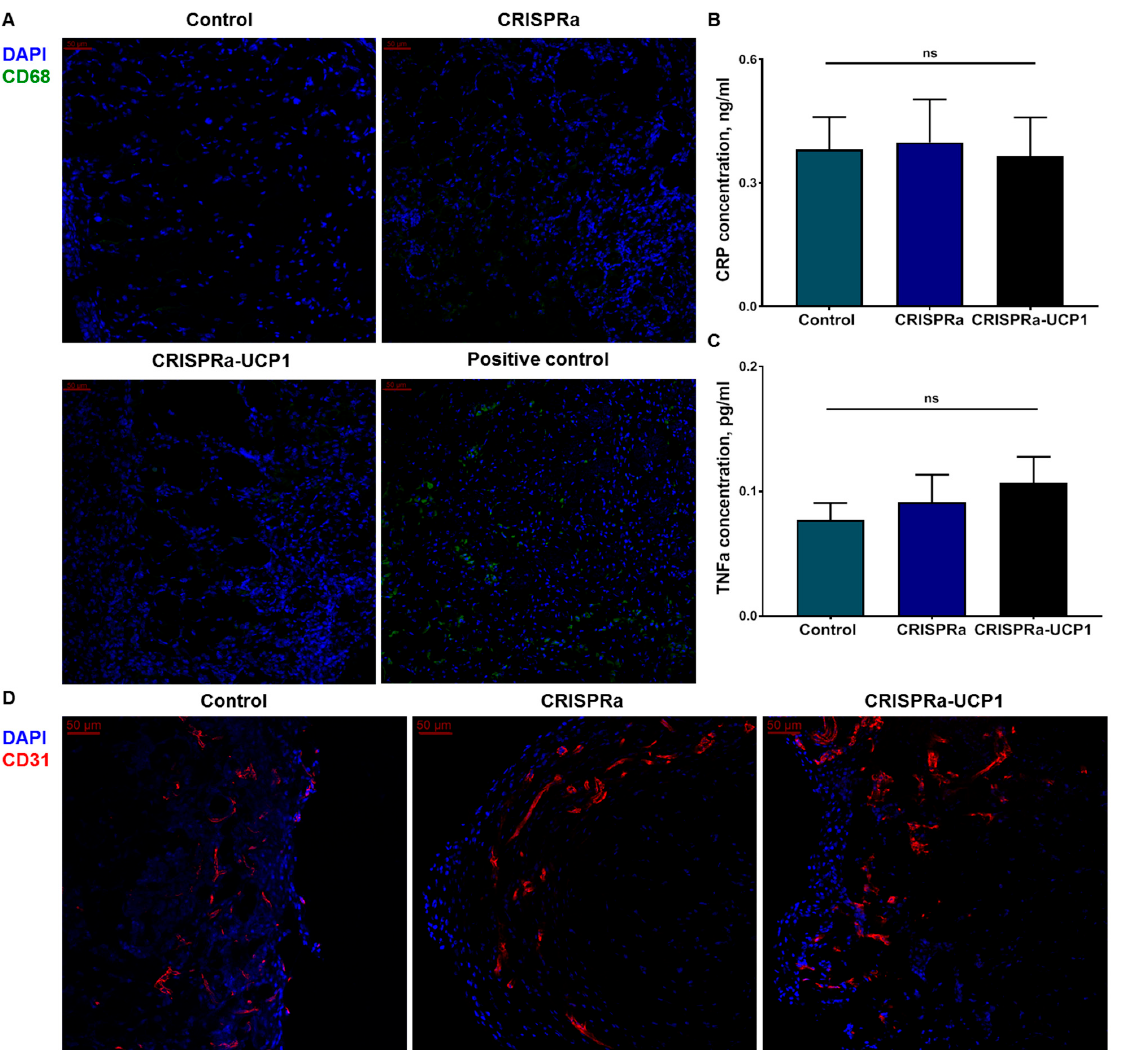
Figure 5. Transplantation of CRISPRa-UCP1-modified adipocytes does not induce inflammation. ( A ) Representative images of graft sections stained for CD68 and DAPI, scale bar 50 μ m; ( B ) con- centration of C-reactive protein in plasma 8 days after transplantation; ( C ) concentration of tumor necrosis factor a in plasma 8 days after transplantation; ( D ) representative images of graft sections stained for CD31 and DAPI, scale bar 50 um. Data are represented as mean ± SEM, Kruskel–Wallis test with post-hoc Dunn’s test; ns—non-significant difference.